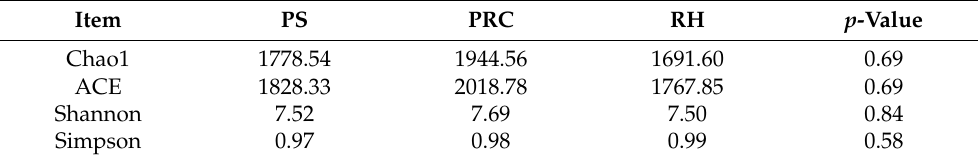
Table 3. Chao 1 richness, ACE richness, Shannon and Simpson diversity of colostrum samples.